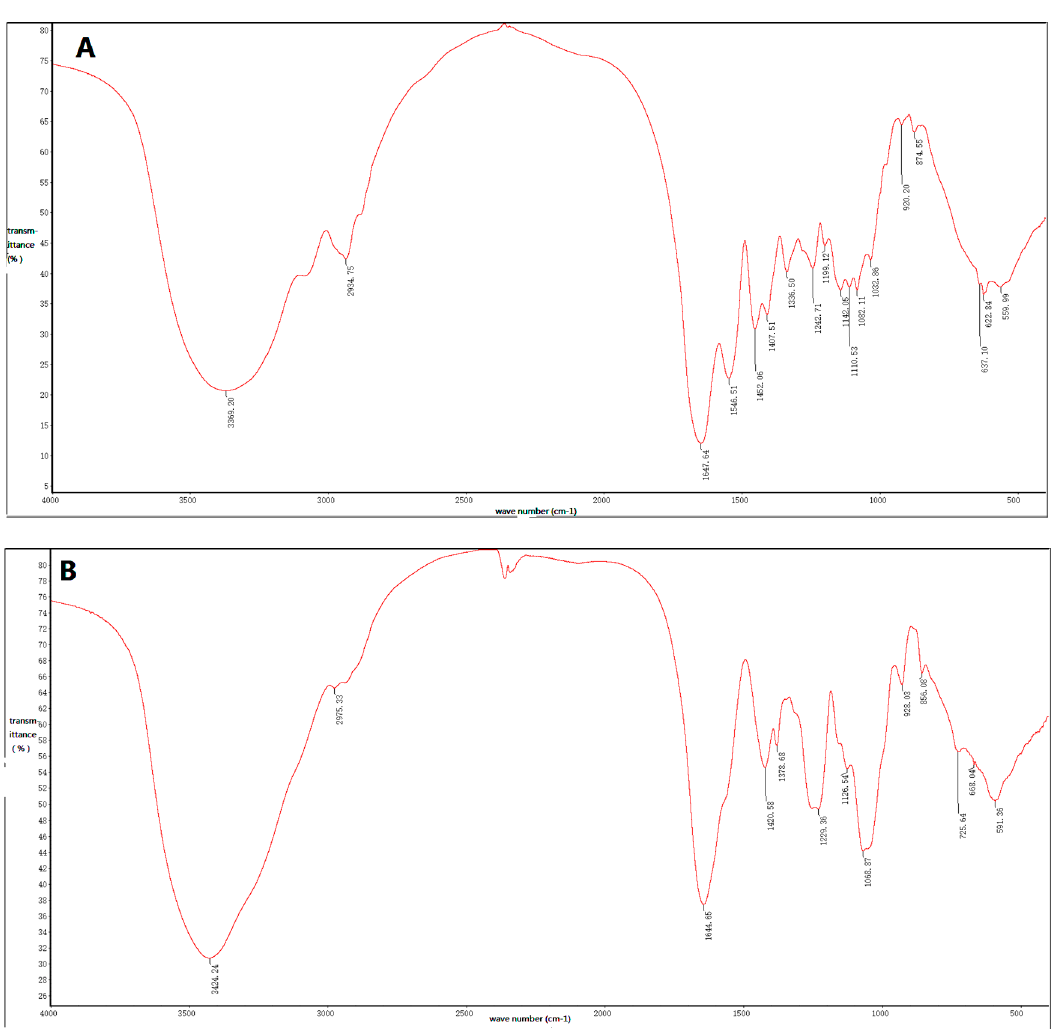
Figure 4. Fourier-transform infrared spectroscopy of ( A ) IOEP1 and ( B ) IOEP2.